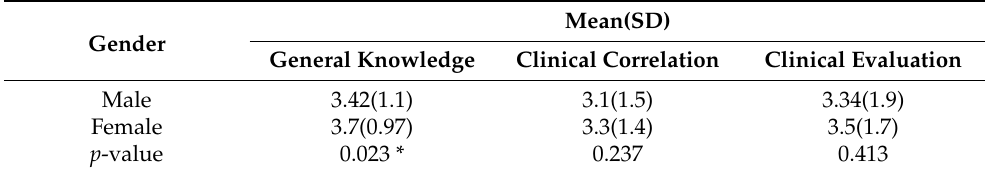
Table 2. Average score for each section by gender.